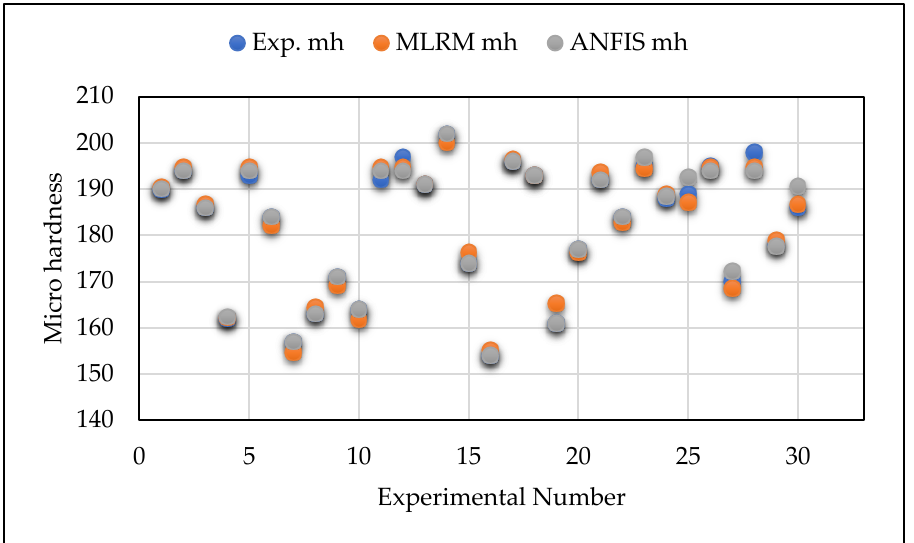
Figure 10. Comparison of ANFIS and MLRM predicted vs. experimentally measured micro hardness values.